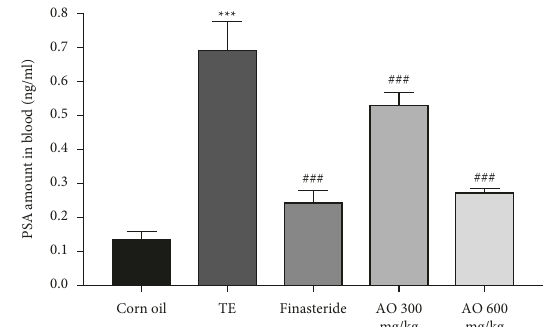
Figure 4: PSA level on the 28th day of experiment; normal control (corn oil), disease (testosterone group), finasteride, and extract with 300 and 600mg/kg (AO) groups. AO extracts were significantly different from the disease group ( p < 0 .